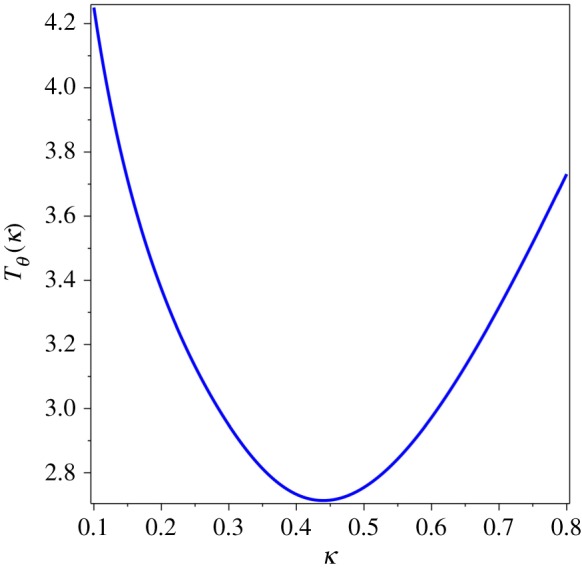
TΘ(κ) = κ(8.31/Θ(1/κ))1/3.